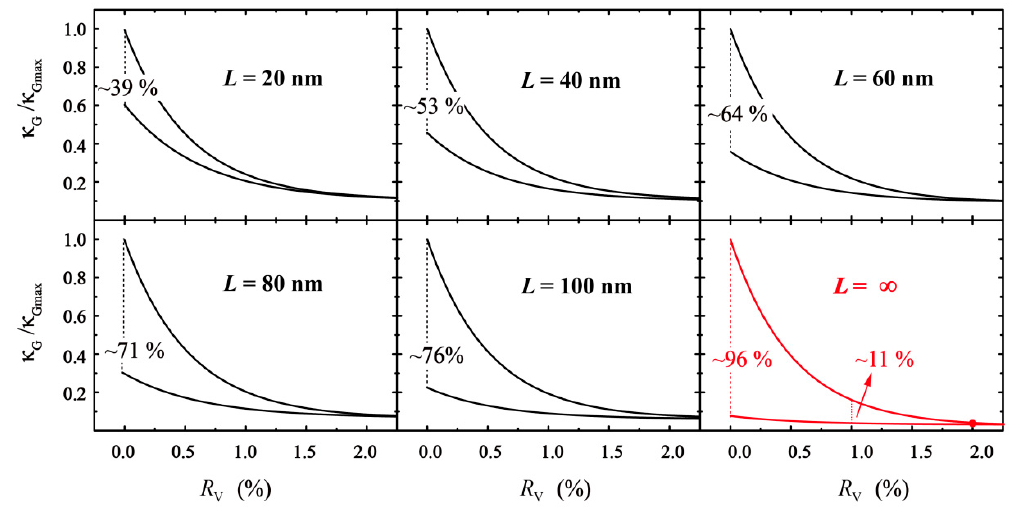
Figure 7. Relative thermal conductivity in different sample sizes.